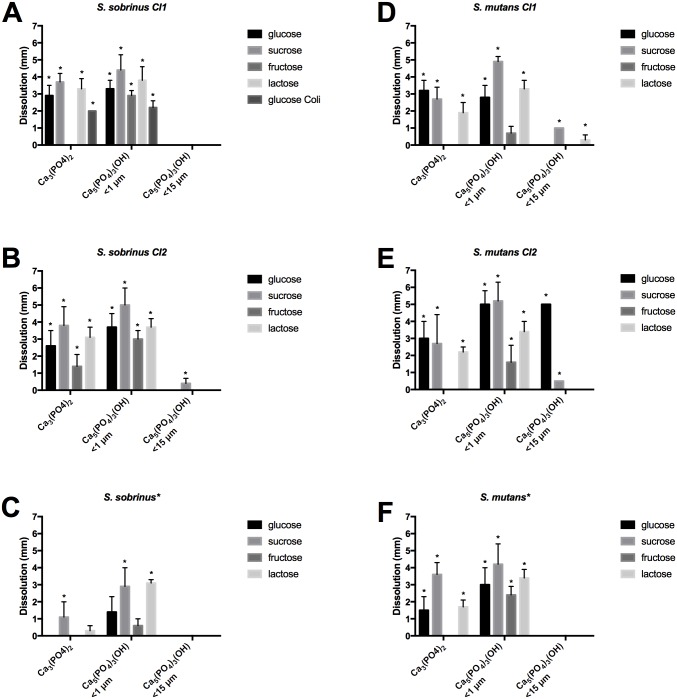
Calcium dissolution by caries-associated mutans streptococci (S. sobrinus (A—C) and S. mutans (E—F)) was investigated by measuring dissolution zones (mm; mean ± SD) on Pikovskaya’s agar in the presence of four different sugars.Asterisks next to the name mark type strains; CI indicates clinical isolates used. Statistically significant differences (p < 0.05) are noted with an asterisk. No dissolution was detected for A. actinomycetemcomitans or Candida spp. N = 10.